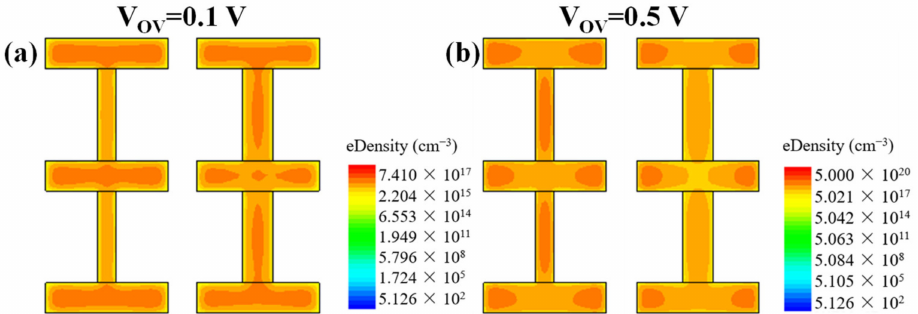
Figure 5. Electron density of channel cross sections with W IB = 3/5 nm (from left to right) at S NS = 15 nm at ( a ) V OV = 0.1 V and ( b ) V OV = 0.5